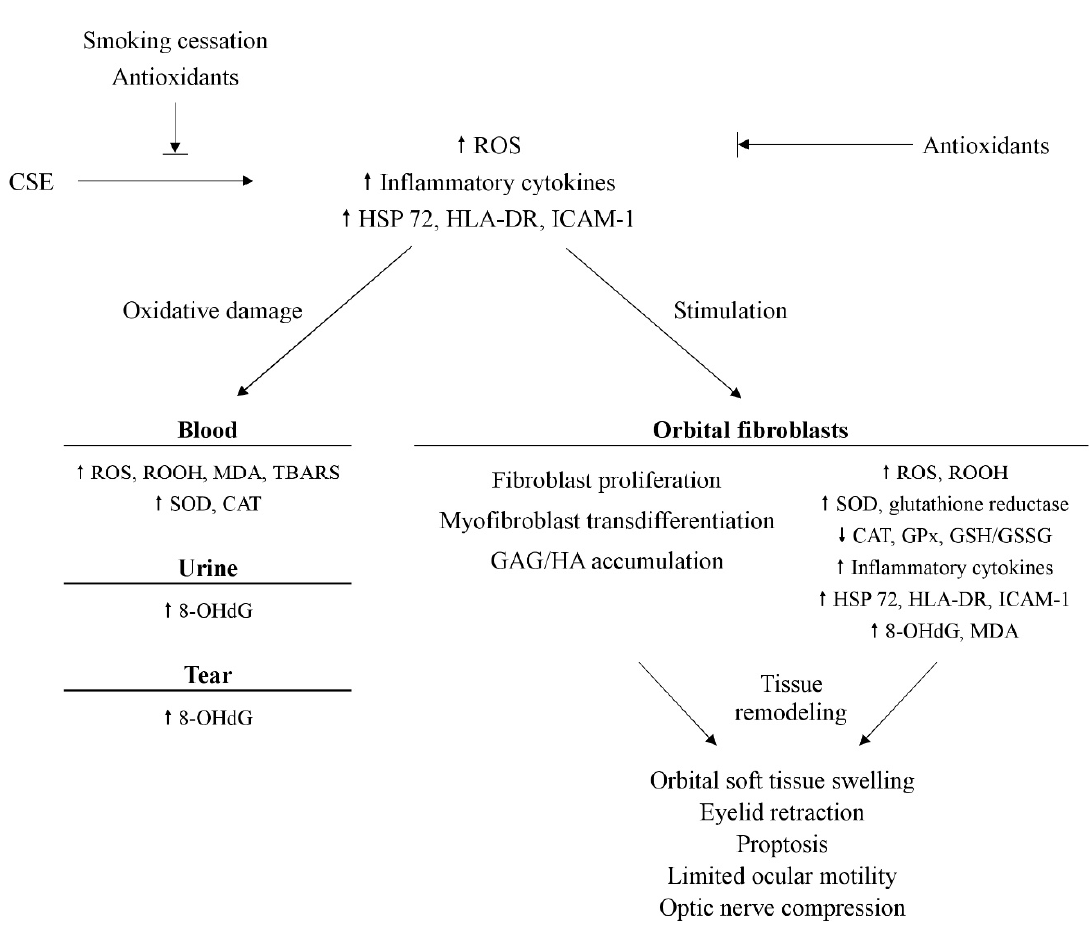
Figure 1. Overview of the potential mechanism of oxidative stress and possible parameters in Graves’ ophthalmopathy. OHdG: 8-hydroxy-2 ′ -deoxyquanosine. CAT: catalase. CSE: cigarette smoke extract. GAG: glycosaminoglycans. GPx: glutathione peroxidase. GSH: glutathione. GSSG: glutathione disulfide. HA: hyaluronic acid. HLA-DR: human leukocyte antigen-DR. HSP 72: heat shock protein 72. ICAM-1: intercellular adhesion molecule-1. MDA: malondialdehyde. ROOH: lipid hydroperoxide. ROS: reactive oxygen species. SOD: superoxide dismutase. TBARS: thiobarbituric acid-reacting sub- stances.